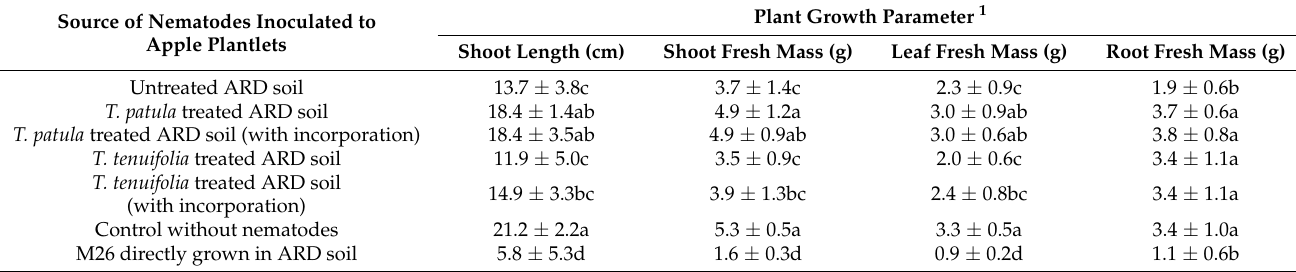
Table 3. Effect of preceding Tagetes patula or T. tenuifolia cultivation in apple replant disease (ARD) soil, and incorporation into soil after growth, on nematode communities with respect to their inhibitory effect on the growth of apple M26 plantlets. Source of Nematodes Inoculated to Apple